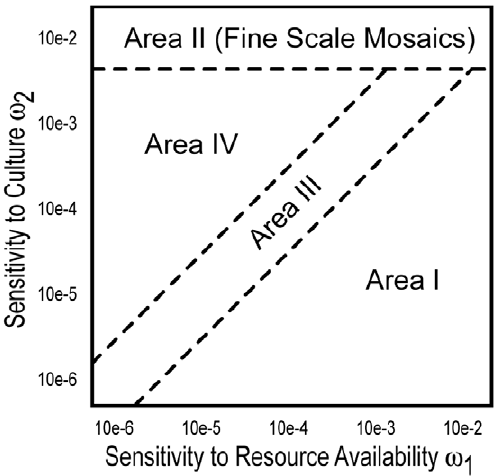
Figure 2. Parametric Regions. The schematic drawing indicates areas in parametric space ( v 1 , v 2 ) that tend to produce similar outcomes. Area I corresponds to the default scenario where sensitivity to resource availability exceeds that of sensitivity to song similarity. Area II is a phenomenological threshold where fine scale mosaics develop. Area III corresponds to when there is a comparable emphasis on resource and cultural needs during movement. Area IV represents parameter combinations with a greater emphasis on cultural needs during movement but not producing fine scale mosaics.